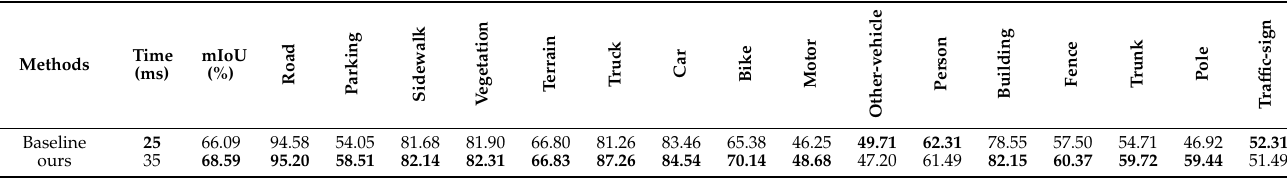
Table A1. Comparison with baseline on the full test dataset.